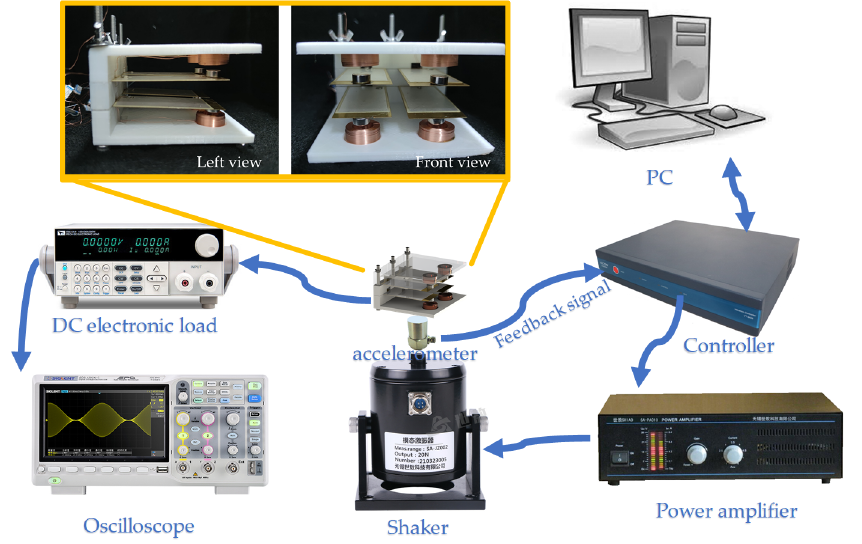
Figure 3. Images of the 2 × 2 array piezoelectric–electromagnetic hybrid energy